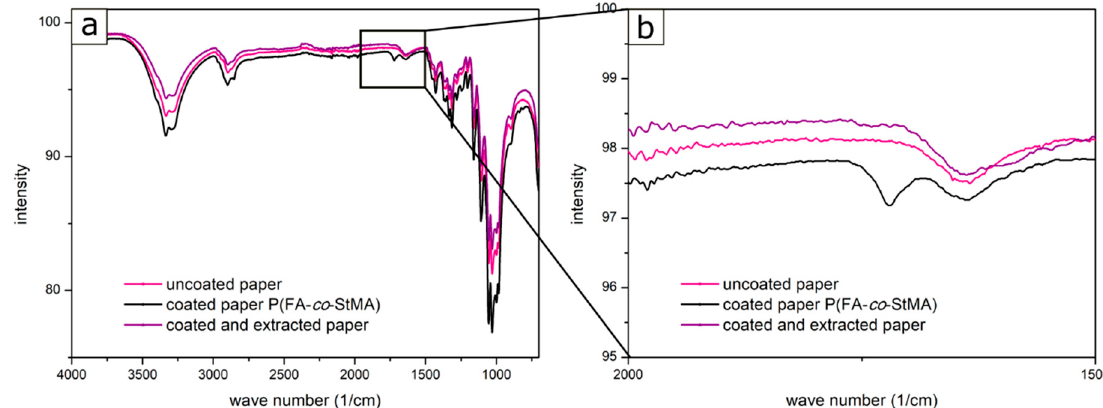
Figure 10. ( a ) IR spectra of the uncoated cellulose fiber substrate (pink), the cellulose fiber coated with P(FA- co -StMA) (black), and the cellulose fiber coated and extracted (violet) featuring a signal at 1700 cm − 1 for the carbonyl-vibes and ( b ) magnification of the area at 1700 cm − 1 .